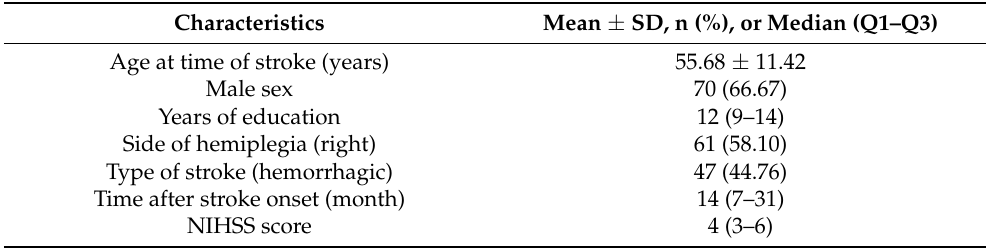
Table 2. Descriptive and inferential statistics of baseline measurements among recovery groups.